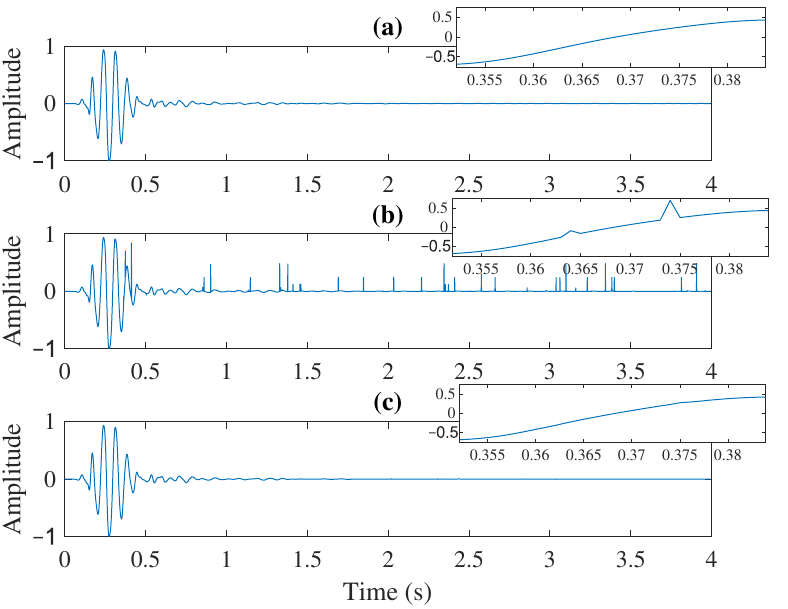
Figure 7. Single trace SNR enhancement (SNR of received data is − 5 dB). ( a ) Original trace. ( b ) Re- constructed trace after MLSE. ( c ) Reconstructed trace after SNR enhancement. On the right side: zoomed view of panels ( a – c ).